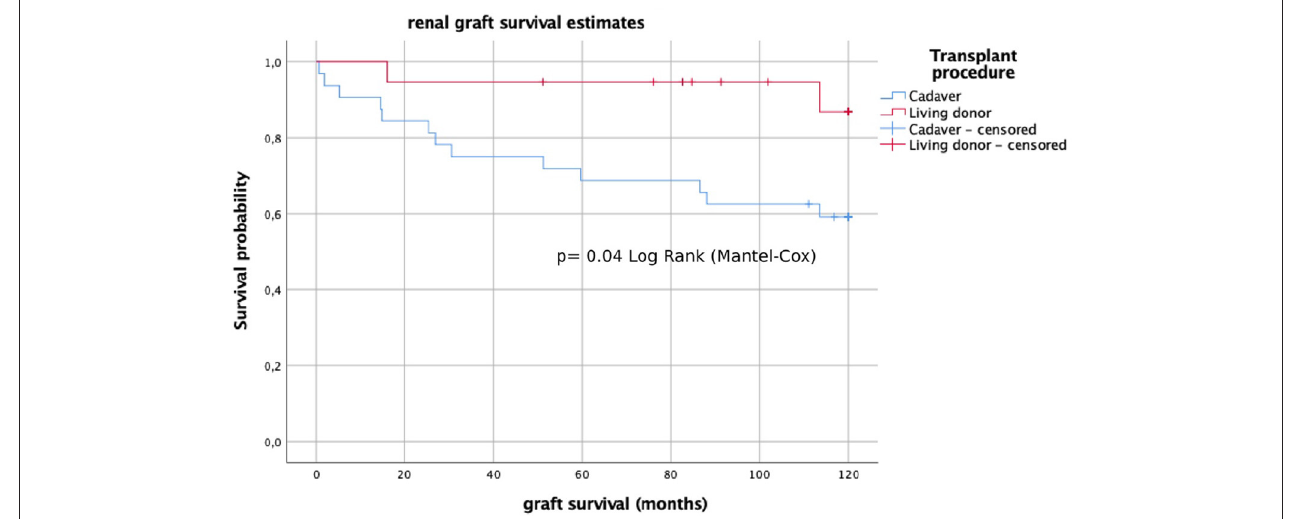
FIGURE 3 | Long-term graft survival (Kaplan–Meier analysis) of living-donor and cadaveric